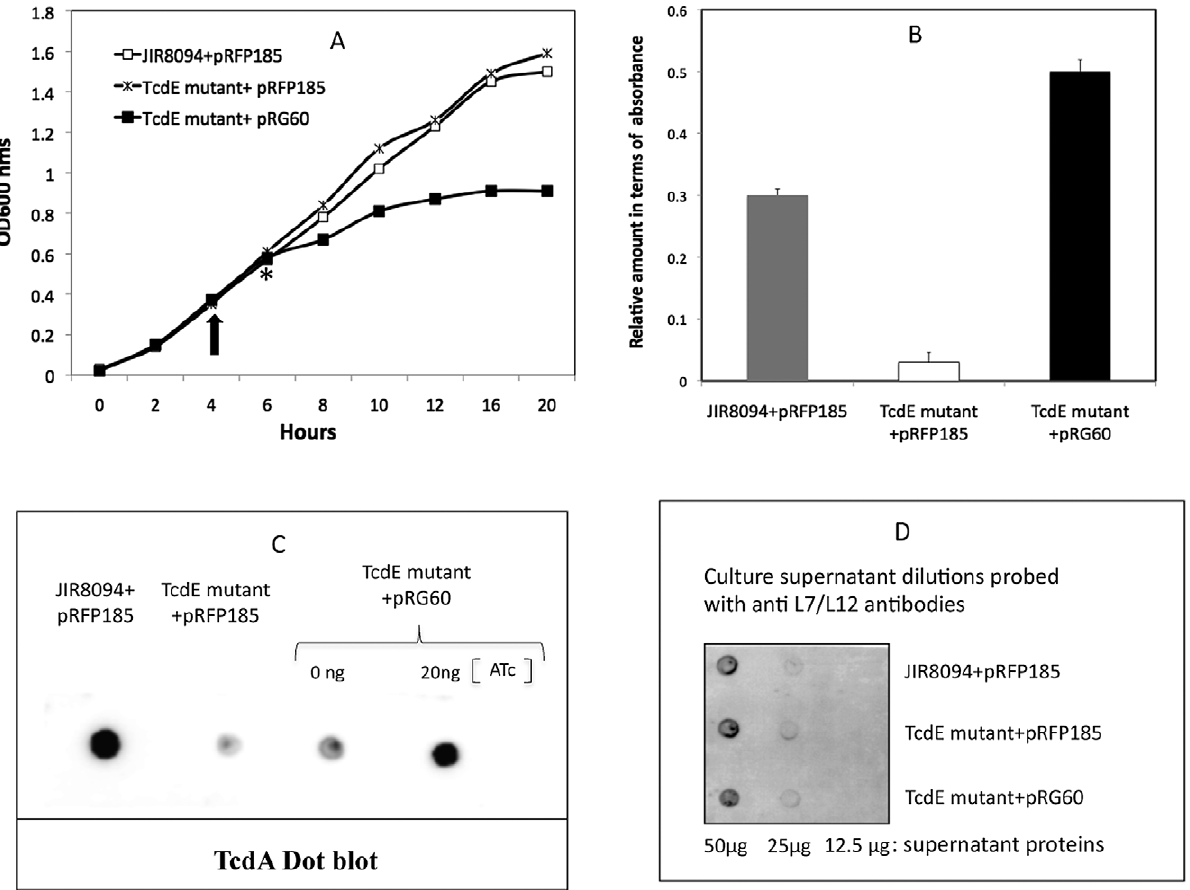
Figure 4. Complementation of TcdE mutant. A Growth curve of parent, the TcdE mutant and the complemented TcdE mutant strains. A. The inducer ATc (20 ng/ml) was added to bacterial cultures at 4 hrs after inoculation, indicated by an arrow. The star * indicates the time point when the cultures were harvested for toxin release analysis. B. Toxins were quantified by ELISA from supernatants of bacterial cultures induced by 20 ng/ml ATc for 2 hours. The signal from the test was recorded as absorbance at 450 nm. The data shown are the mean + / 2 standard error of three replicative samples. C. Dot blots of culture supernatants of the parental, the TcdE mutant and the complemented TcdE mutant, induced or not induced by ATc (0 and 20 ng/ml), with monoclonal anti-TcdA. D. Dot blots of samples in B with monoclonal antibodies against L7/L12 ribosomal